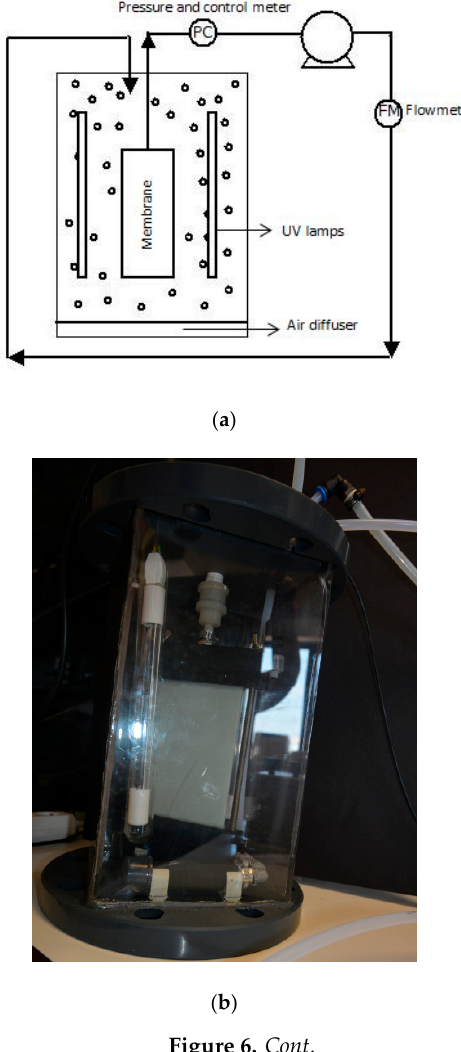
Feed ( c ) Figure 6. Submerged membrane photocatalytic reactor ( a , b ) and photocatalytic membrane ( c ), developed and tested to treat olive mill wastewaters.